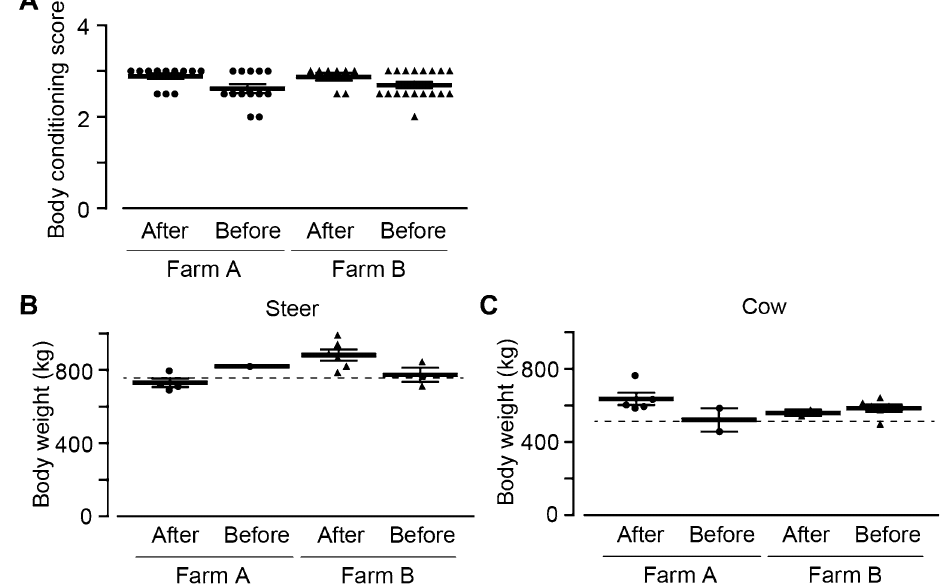
Figure 2. The physique status of exposed cattle. The body conditioning score (BCS) and body weight of exposed cattle were investigated. ( A ) The summary of BCS (Farm A, black circle, n = 14 and 13; Farm B, black triangle, n = 8 and 18). ( B ) The summary of body weight of steer (Farm A, black circle, n = 4 and 1; Farm B, black triangle, n = 6 and 3). ( C ) The summary of body weight of cow (Farm A, black circle, n = 5 and 2; Farm B, black triangle, n = 2 and 6). Broken line, the average weight of Japanese black cattle. Data are presented as mean ±